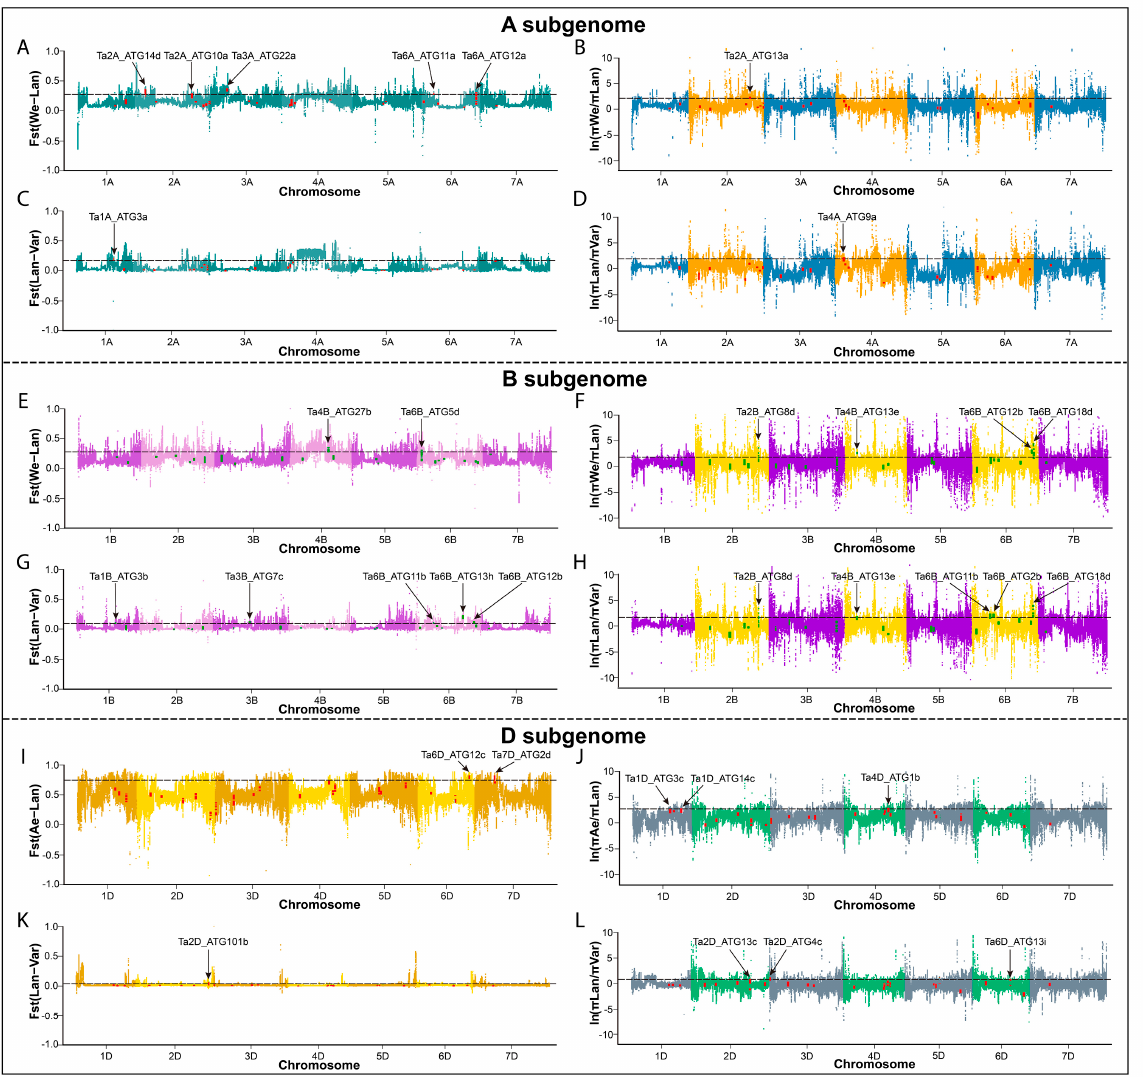
Figure 5. Distribution of TaATGs among genome-wide selective signals during domestication and breeding processes of wheat. ( A , B , E , F , I , J ) The fst and ln π ratios between wild emmer and a landrace were used to evaluate the domestication of wheat. ( C , D , G , H , K , L ) The fst and ln π ratio between a landrace and a variety were used to evaluate wheat’s improvement. Resequencing reads were mapped to the A,B and D subgenomes of wheat according to chromosome origin. All 77 TaATGs were highlighted against the position on each of the 21 chromosomes in different colors. The top 10% of the genome-wide value was taken as the threshold for selective sweeps and is shown as horizontal black dashed lines. The TaATGs above the threshold line are